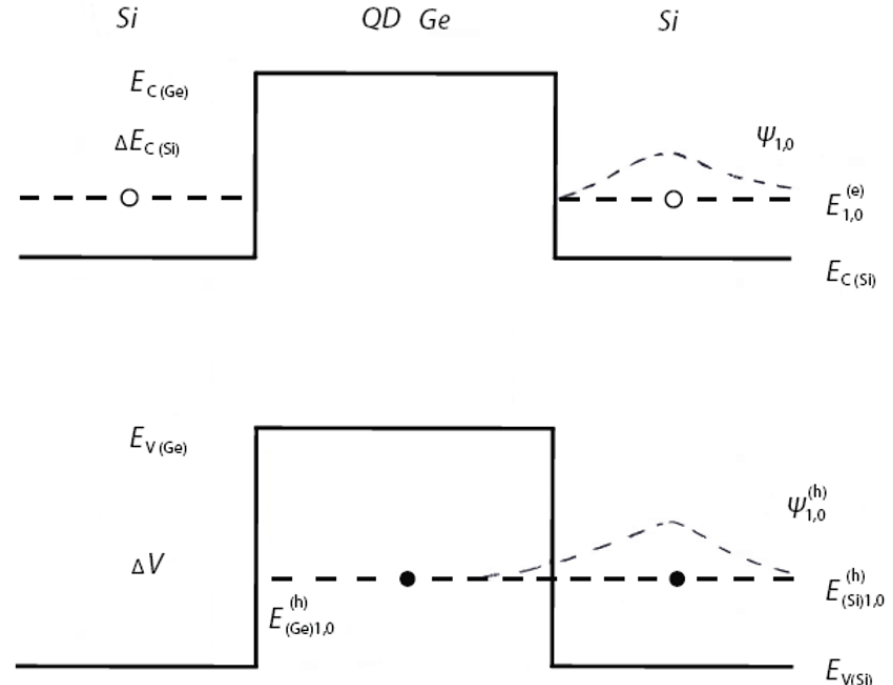
Figure 1. Band diagram of a nanoheterostructure containing a single germanium quantum dot (QD) grown in a silicon matrix. In the nanoheterostructure, the QD is a potential well for a hole (denoted by • ) and a potential barrier for an electron (denoted by ). The energies E c ( Ge ) , E v ( Ge ) and E c ( Si ) , E v ( Si ) correspond to the positions of the bottom of the conduction band and the top of the valence band of the silicon matrix and germanium QD, respectively. ∆ E c ( Si ) and ∆ V , respectively, represent the shift of the bottom of the conduction band in the silicon matrix relative to the bottom of the conduction band of germanium QDs and shift of the top of the valence band in the silicon matrix relative to the top of the valence band of the QD of germanium. E 1,0 ( e ) and E ( Si ) 1,0 ( h ) , E ( Ge ) 1,0 ( h ) , respectively, represent the position of the level of an electron in the conduction band of the silicon matrix and the position of the level of a hole in the bandgap of the silicon matrix, and the position of the level of a hole in the valence band of the QD of germanium. The figure also shows (dotted line) the distributions of the wave function Ψ 1,0 of an electron located in the conduction band of the silicon matrix and the wave function Ψ 1,0 ( h ) of a hole located in the bandgap of the silicon